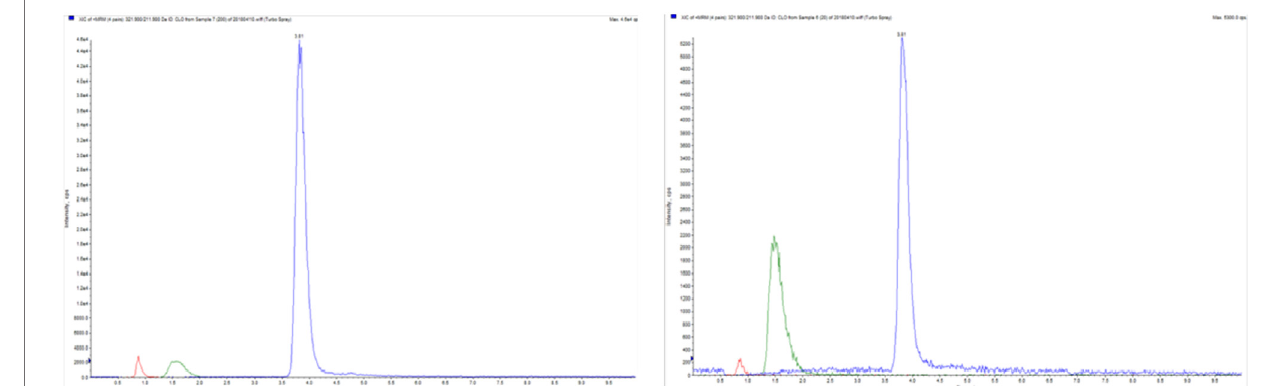
FIGURE 6 | Clopidogrel thiol metabolite (H4)